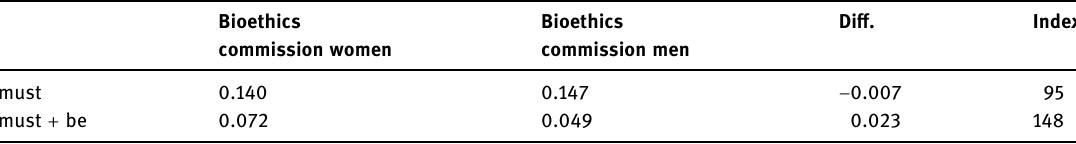
Table 30: Most frequent collocation with “ must ” as per cent of total tokens ( normalised, n = 1,000 )